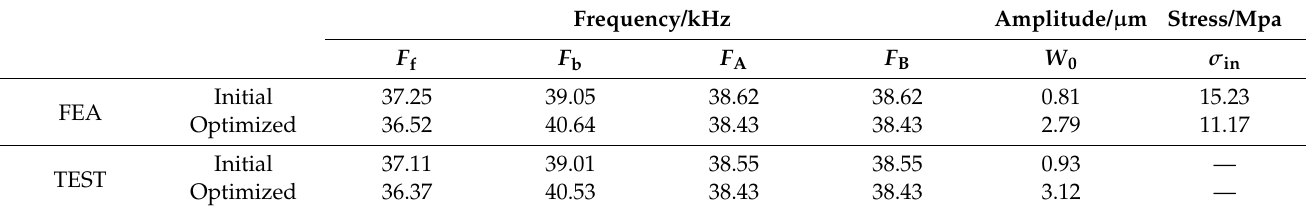
Figure 7. Vibration test platform for the optimized stator of the HUM. Table 3. Comparison of experimental and FEA